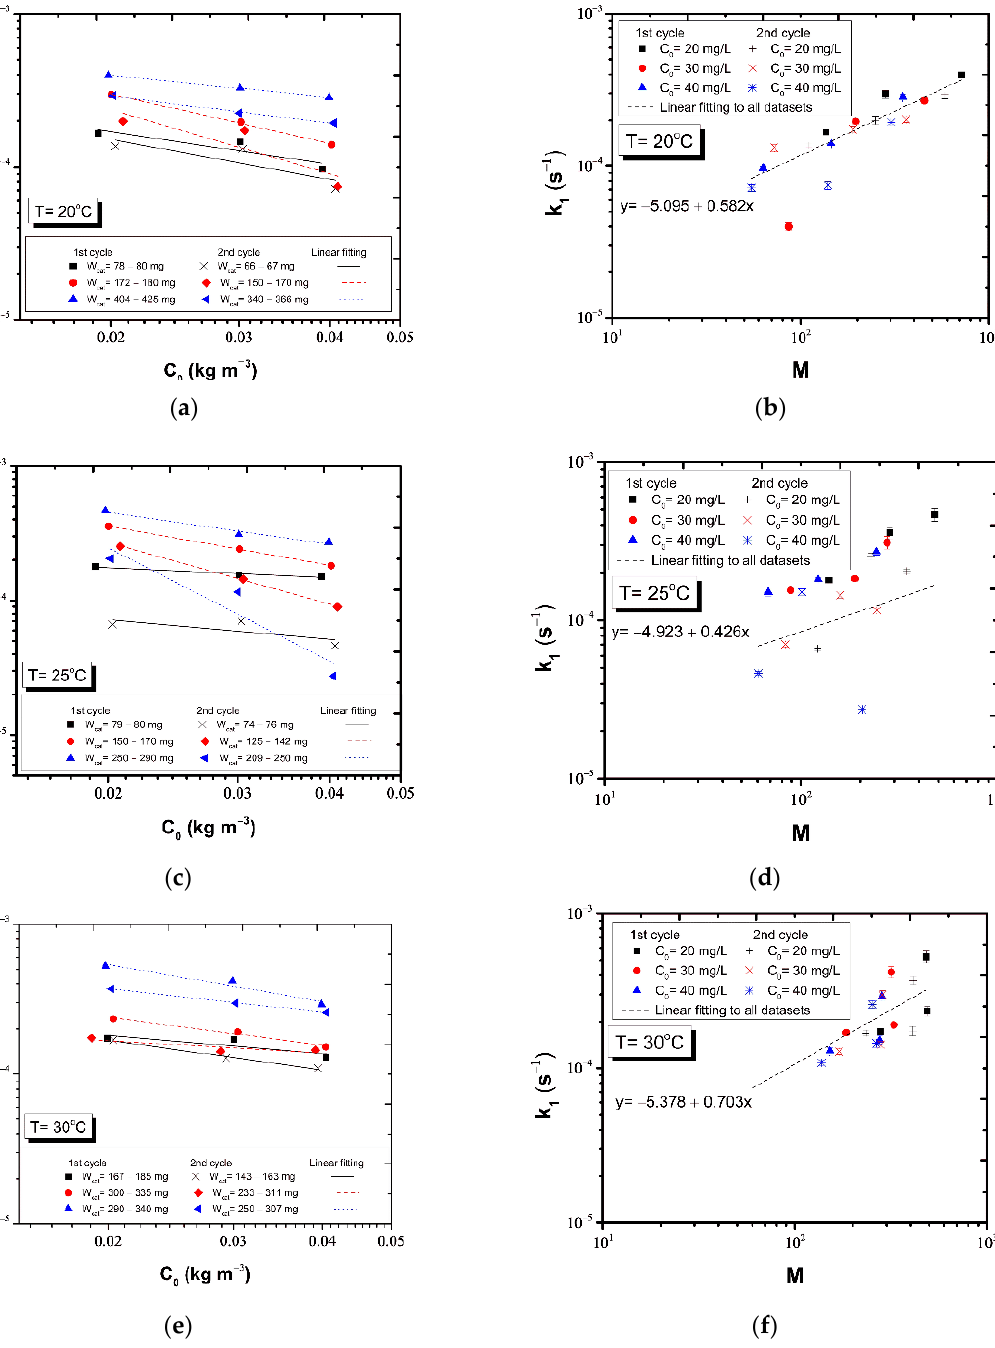
Figure 10. Plots of the apparent first order rate constant vs. the initial phenol concentration at temperature ( a ) 20 °C ( c ) 25 °C ( e ) 30 °C. Plots of the apparent first order kinetic constants vs. the ratio M at temperature ( b ) 20 °C ( d ) 25 °C ( f ) 30 °C. Table 4. Summary of the slopes obtained from linear regression analysis of batch tests.